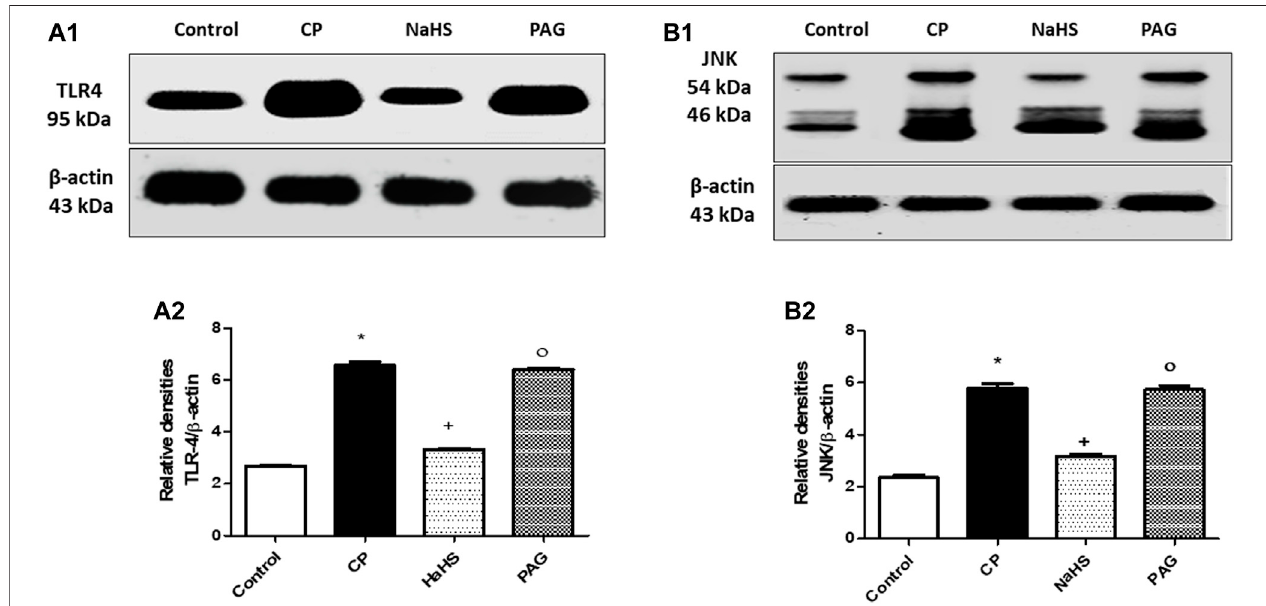
FIGURE 4 | Representative Western blot analysis of the effect of NaHS and PAG on hepatic TLR4 (A) and p-JNK (B) protein expressions in CP-induced hepatotoxicityinrats,showingproteinbandsofeach group(upperpanel) andgraphspresent theirdensitometric analysis(lowerpanel).Dataarerepresentedasmean± SEM.*,+, ° aresigni fi cantlydifferentfromcontrol,CPandNaHSgroups,respectively,wheren=6and p < 0.05.CP;cyclophosphamide,PAG;DL-propargylglycine,TLR4; Toll-like receptor4, p-JNK; phosphorylated Jun N-terminal kinase.